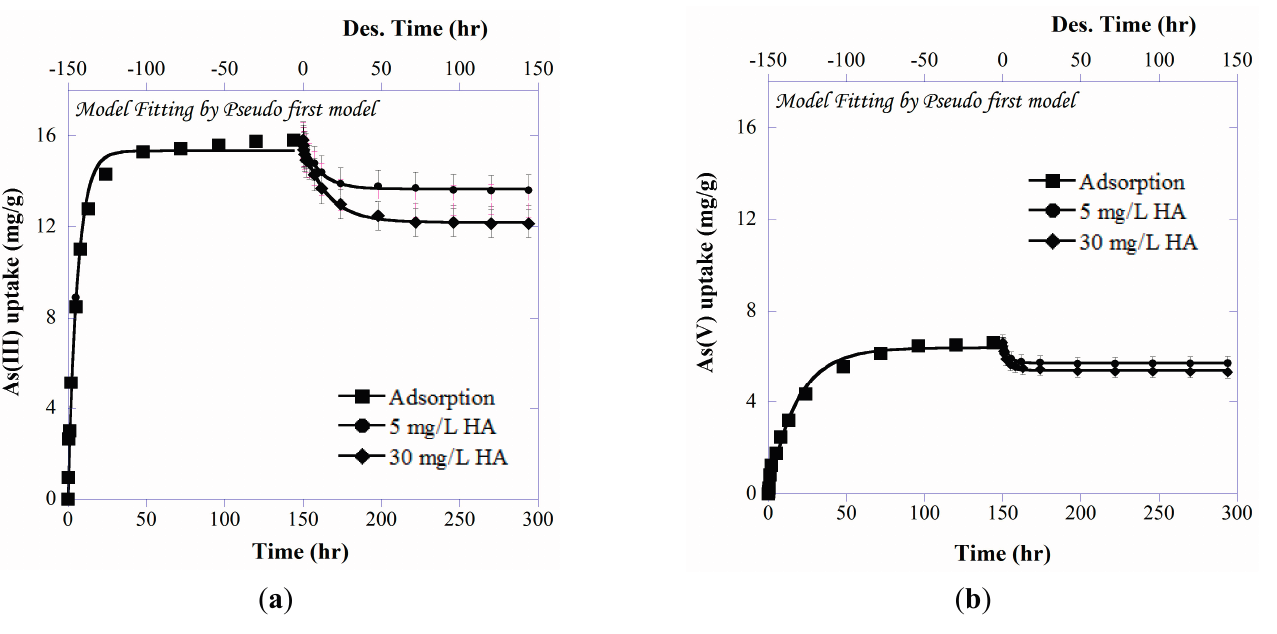
Figure 7. ( a ) As(III) and ( b ) As(V) adsorption–desorption curves at pH 7.5 and room temperature. The zero point on second x-axis indicates the time of HA addition. Lines in the adsorption/desorption show predictions using pseudo first order sorption kinetic model.